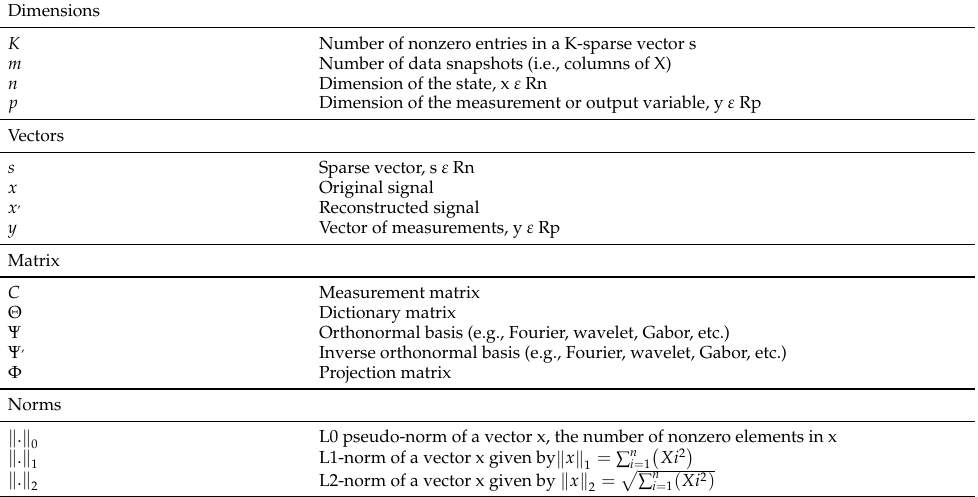
Table 3. Notations used in this